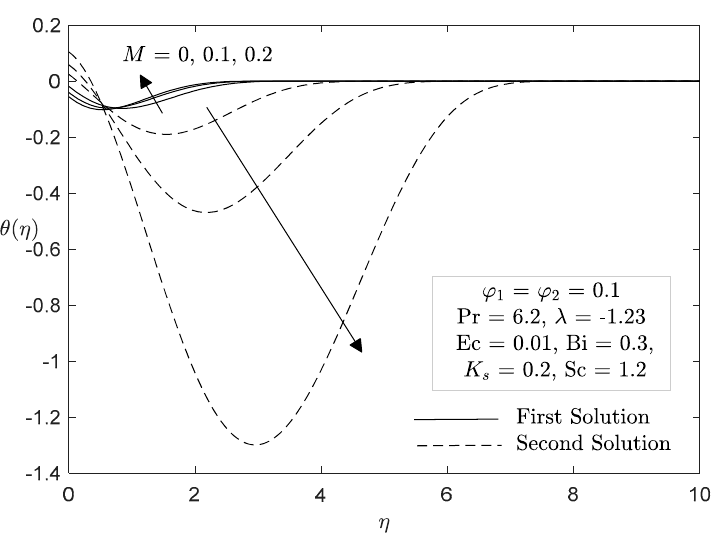
Figure 10. Temperature profile for various values of M .